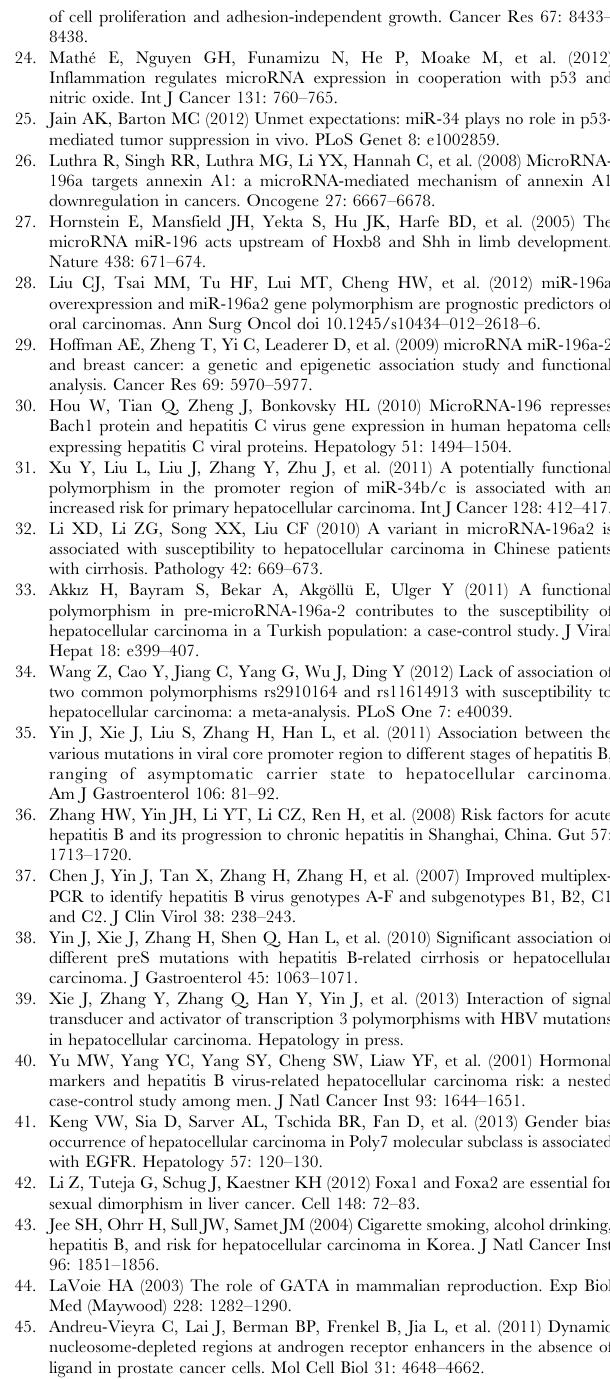
Table S4 Association of multiplicative interaction of pri-miR-34b/c rs4938723 and pre-miR-196a2 rs11614913 with HCC risk in multivariate regression analyses.